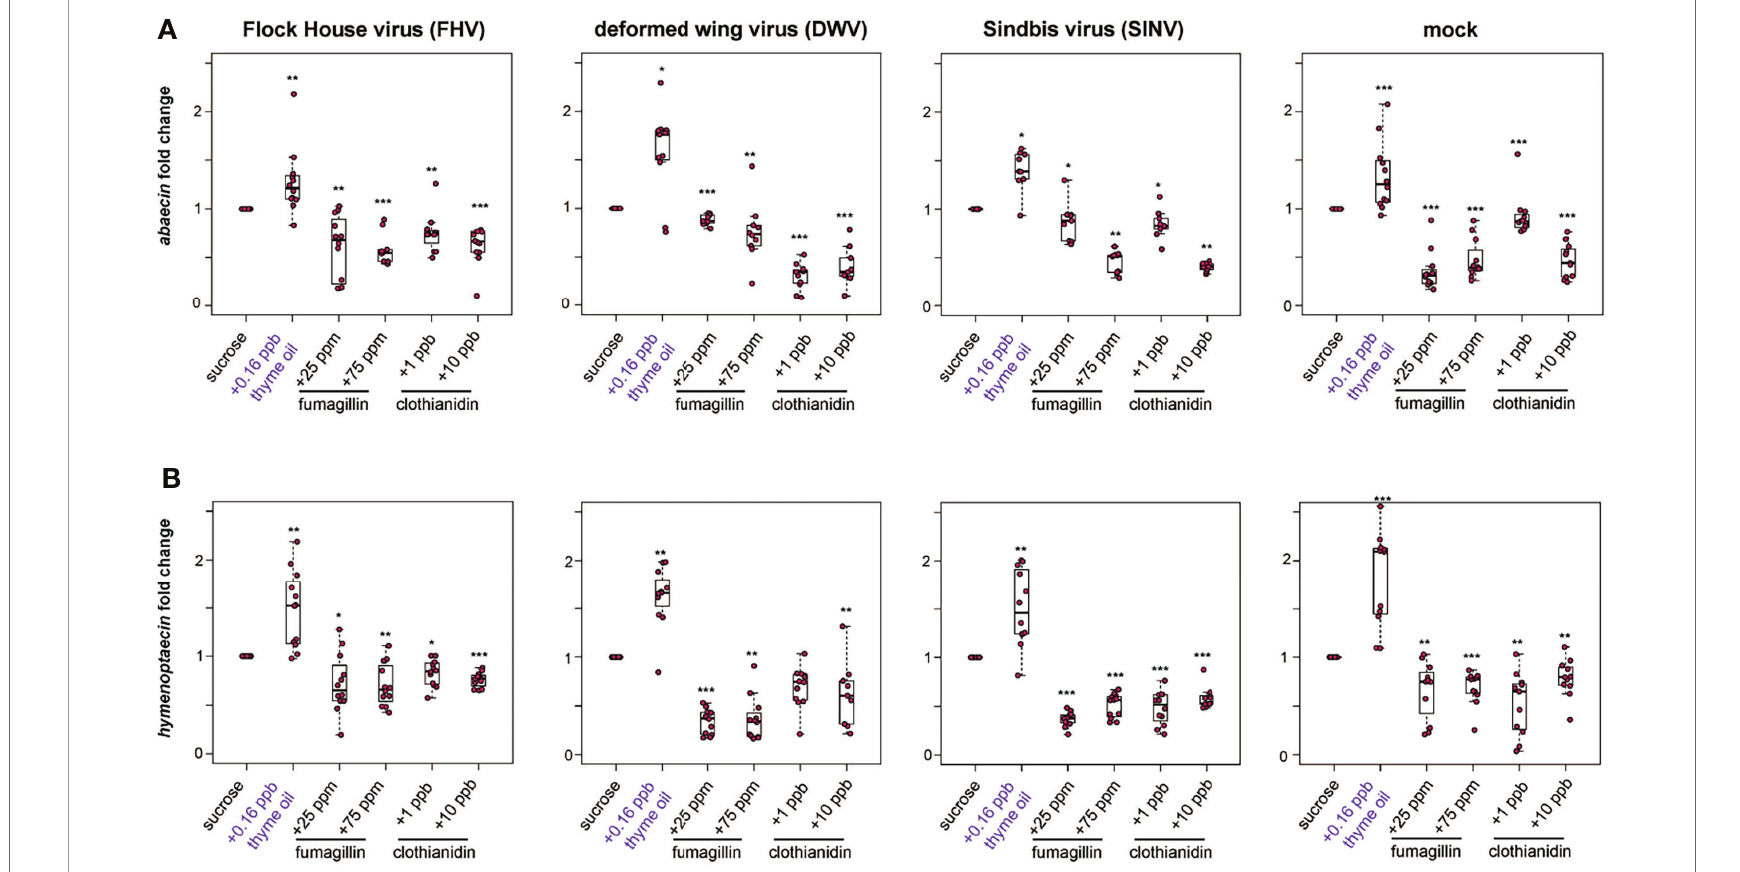
FIGURE 5 | Expression of antimicrobial peptides encoding genes was greater in bees fed thyme oil augmented sucrose syrup and lower in bees fed fumagillin or clothianidin containing sucrose syrup. The expression of two antimicrobial peptides ( abaecin and hymenoptaecin ) was assessed in mock and virus-infected bees fed sucrose syrup containing additives. (A) In virus- and mock-infected bees (i.e., FHV, DWV, SINV), abaecin expression was higher in bees fed sucrose syrup containing thyme oil and lower in bees fed sucrose syrup containing fumagillin (25 ppm or 75 ppm) or clothianidin (1 ppb or 10 ppb) compared to bees fed sucrose only. (B) In virus-infected bees (i.e., FHV, DWV, SINV), hymenoptaecin expression was higher in bees fed sucrose syrup containing thyme oil and lower in bees fed sucrose syrup containing fumagillin (25 ppm or 75 ppm) or clothianidin (1 ppb or 10 ppb). Hymenoptaecin expression was higher in mock-infected bees fed sucrose syrup augmented with 0.16 ppb thyme oil, but lower in mock-infected bees fed either fumagillin (i.e., 25 ppm or 75 ppm) or clothianidin (1 ppb or 10 ppb) containing sucrose syrup. Data were analyzed by a pairwise Wilcoxon Rank Sums with a Benjamini – Hochberg correction for multiple comparisons. Asterisks indicate a signi fi cant change in gene expression compared to sucrose only control; signi fi cance levels: * p < 0.05; ** p < 0.005; *** p < 0.0005. This fi gure shows representative biological replicate for the expression of each gene (i.e., rep1 for abaecin and rep3 for hymenoptaecin ). The data for one additional biological replicate is presented in Supplemental Figures S7, S8 . Raw data are included in Supplemental Tables S17 – S20